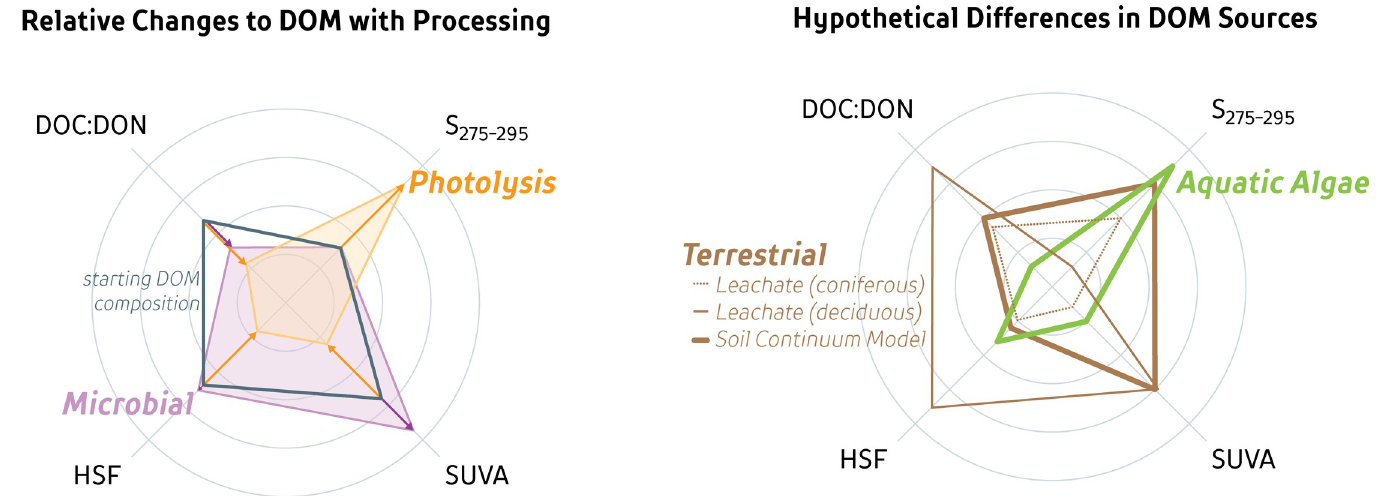
Fig 5. Changes to a composition wheel resulting from photolytic and microbial degradation (left) and differences in terrestrial versus aquatic DOM sources (right). Changes to dissolved organic matter (DOM) (grey) with photolytic (orange; 12 to 18 day exposure to sunlight) or microbial (purple; 30-day experiment) degradation based on experimental incubations of natural DOM samples [51] (left). The mean decrease in DOC concentration was 18% during photolysis and 10% during microbial degradation experiments (n = 11, 9; respectively). Hypothetical differences in DOM sources (right) are based on various leachate experiments in literature [22, 37,